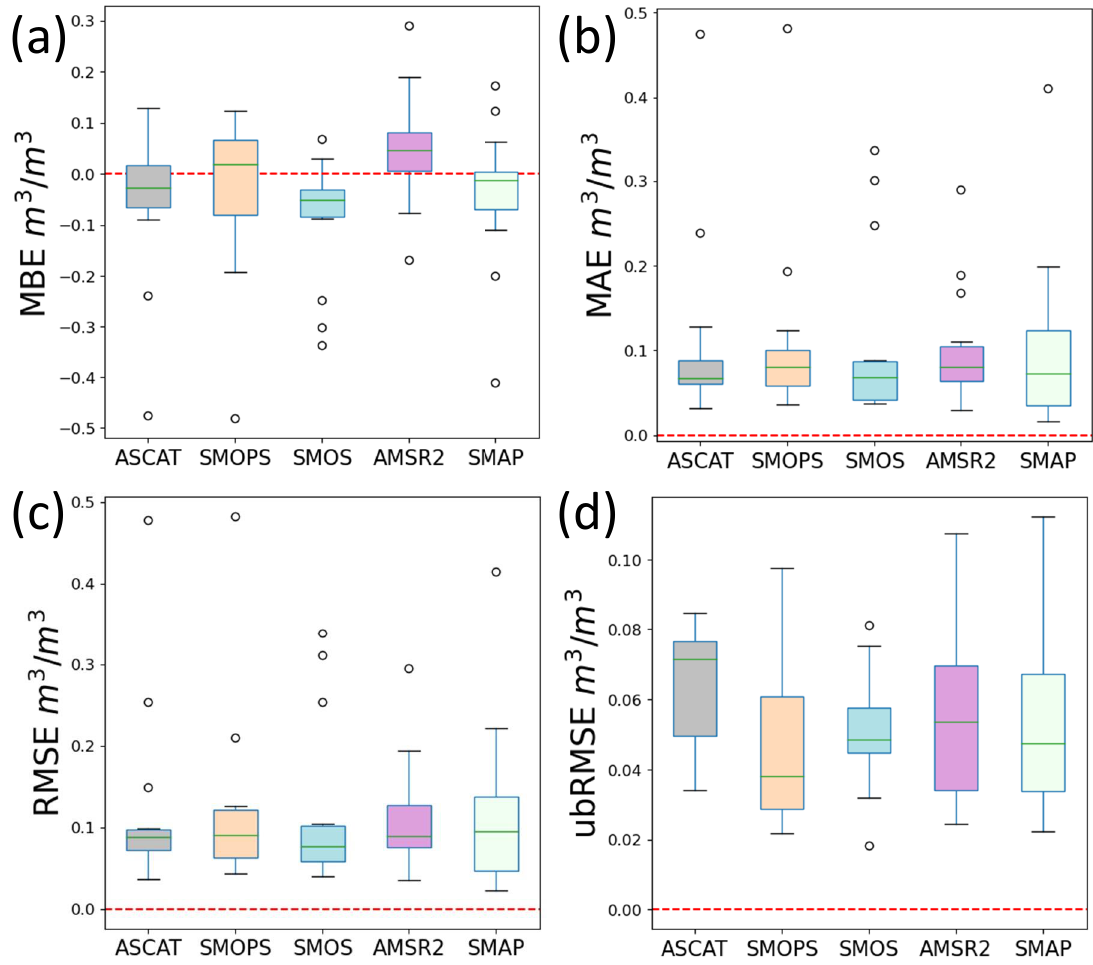
Figure 3. Spatio-temporal box-whisker plots of ( a ) MBE, ( b ) MAE, ( c ) RMSE, and ( d ) ubRMSE with outliers that fall outside the interquartile range depicted as black circles, red dashed line indicates perfect value.